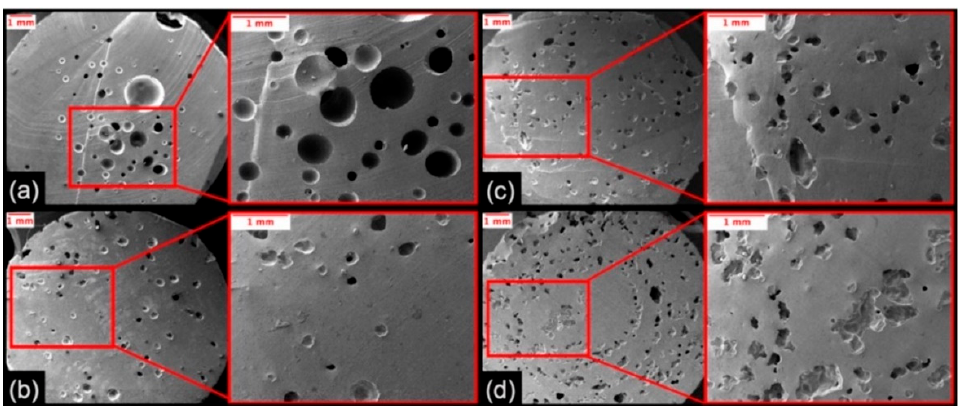
Figure 5. Cross-sectional SEM images of the porosity within nanocomposites containing MWCNT loadings of ( a ) 1.0 wt. %, ( b ) 1.5 wt. %, ( c ) 2.0 wt. %, and ( d ) 2.5 wt.